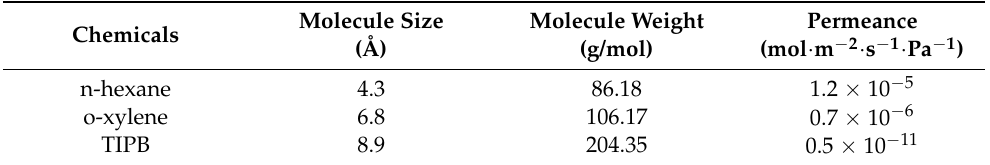
Table 1. List of organic molecules for testing the quality of AlPO-5 membranes and pervaporation flux measured.